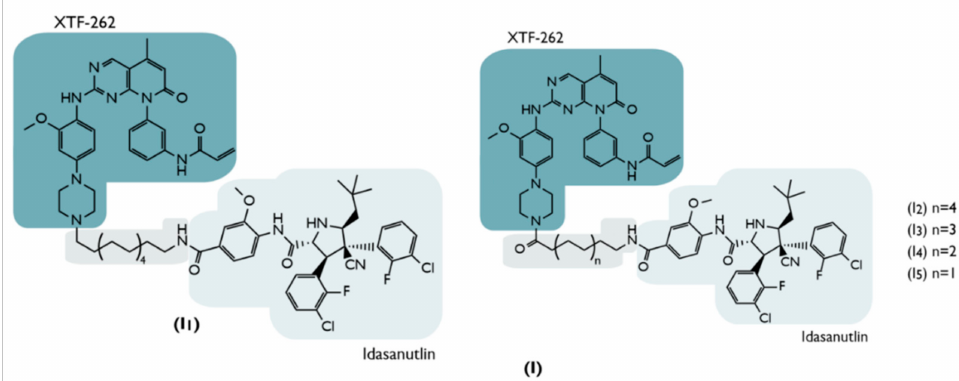
Figure 11. Chemical Structures of PROTACs I. Recruiting the mutated epidermal growth factor receptor protein (EGFR L858R/T790M ) through the XTF-262 inhibitor, and E3 ligase MDM2 through the idasanutlin inhibitor; PROTAC I has different types of linkers that allow us to assess the impact that these have at the level of the biological response generated by the compound